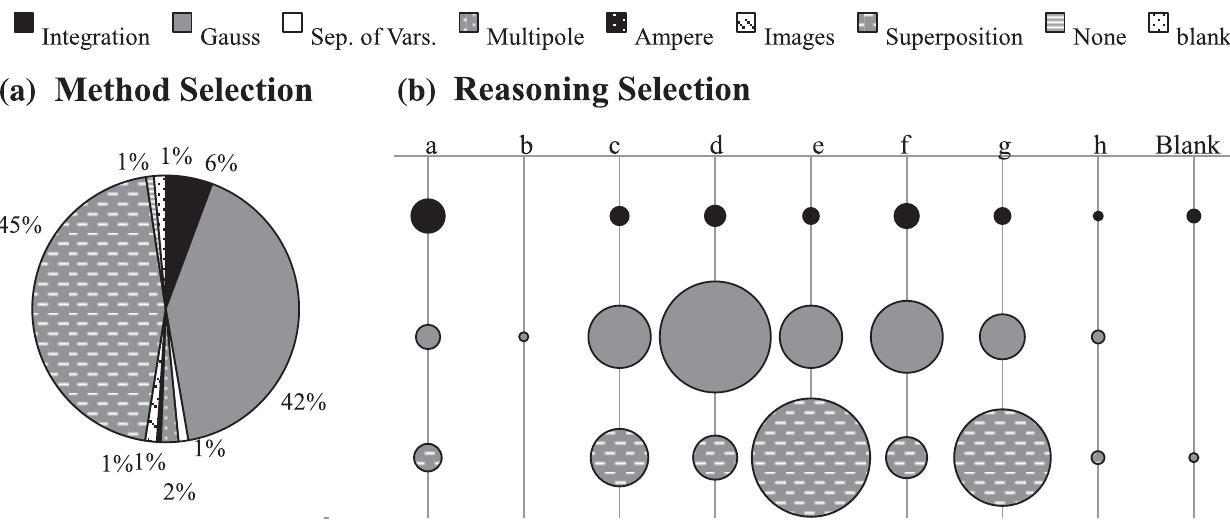
FIG. 5. (a) Method selections for N ¼ 421 students on Q5 (Fig. 1). (b) Reasoning selections for the subset of students who selected each of the three most common methods: direct integration ( N ¼ 24 ), Gauss ’ s law ( N ¼ 176 ), and superposition ( N ¼ 191 ). Number of responses for each reasoning element is proportional to the area of the circle.